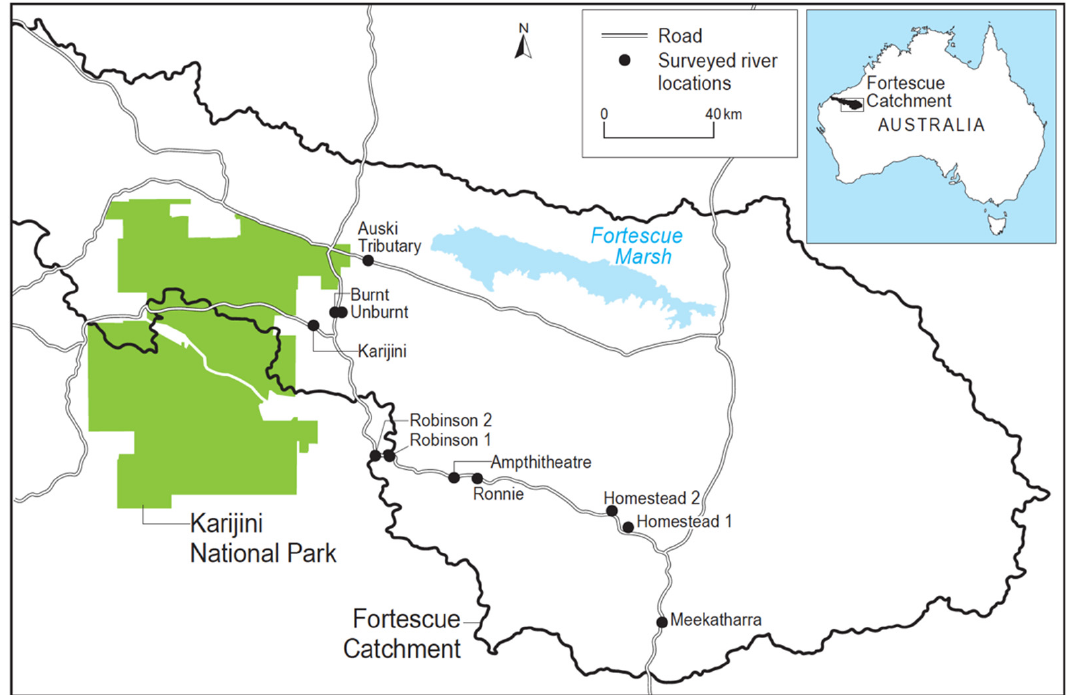
Figure 2. Map of surveyed channels in the Upper Fortescue Catchment, in the Pilbara, Western Aus- tralia.